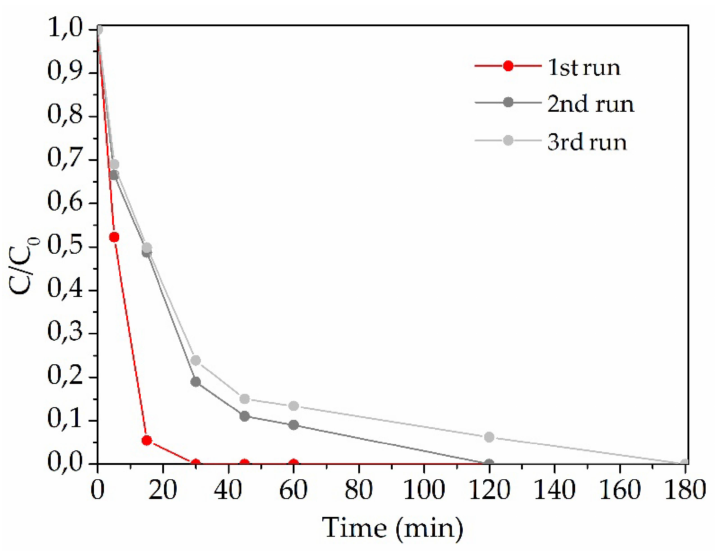
Figure 7. Dimensionless concentration of BrO 3 − during reutilization experiments using 1% Pd/CF1.